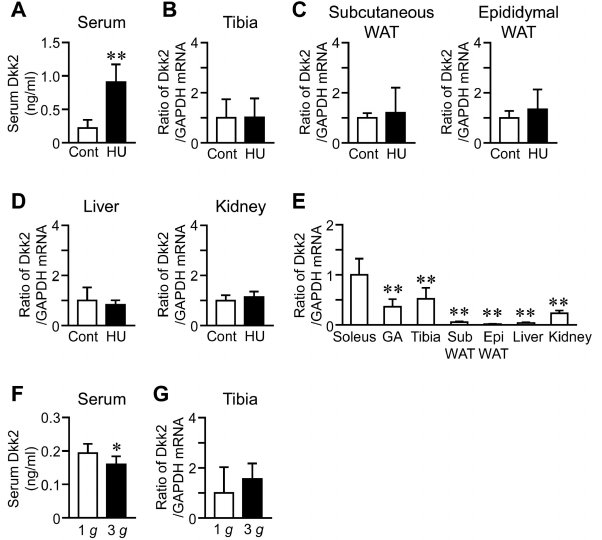
Figure 3. E ff ects of HU and hypergravity on serum as well as Dkk2 mRNA levels in the tibia, subcutaneous and epididymal white adipose tissues (WAT), liver and kidney. ( A ) Serum samples were collected from control (Cont) mice or mice with HU for 3 weeks ( n = 8 mice in each group). Then, quantification of serum Dkk2 levels was performed. The data represent the mean ± SD of eight mice in each group. ** p < 0.01 vs. control group (Mann-Whitney U test). ( B – D ) Total RNA was extracted from the tibia ( B ), subcutaneous and epididymal WAT ( C ), liver and kidney ( D ) of control mice and mice with HU for 3 weeks ( n = 8 mice in each group). Then, real-time PCR analysis of Dkk2 or GAPDH was performed. The data represent the mean ± SD of eight mice in each group. ( E ) Total RNA was extracted from the soleus and gastrocnemius (GA) muscles, tibia, subcutaneous (Sub) WAT, epididymal (Epi) WAT, liver and kidney of control mice ( n = 8 mice in each group). Then, real-time PCR analysis of Dkk2 or GAPDH was performed. The data represent the mean ± SD of eight mice in each group. ** p < 0.01 vs. soleus muscle (Dunnett test). ( F ) Serum samples were collected from mice with exposure to 1 g or 3 g for 4 weeks ( n = 8 mice in each group). Then, quantification of serum Dkk2 levels was performed. The data represent the mean ± SD of eight mice in each group. * p < 0.05 vs. 1 g group (Mann-Whitney U test). ( G ) Total RNA was extracted from the tibia of mice with exposure to 1 g or 3 g for 4 weeks ( n = 8 mice in each group). Then, real-time PCR analysis of Dkk2 or GAPDH was performed. The data represent the mean ± SD of eight mice in each